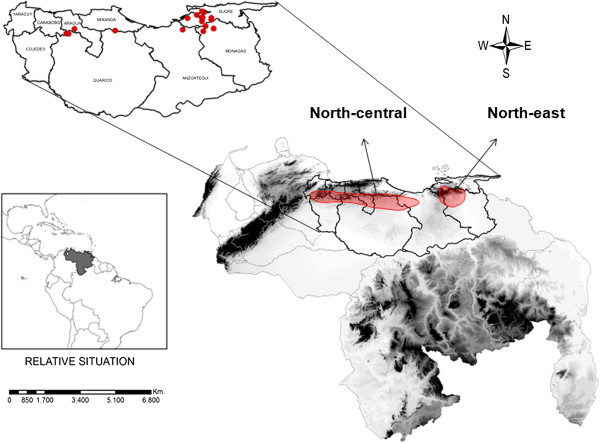
Map of Venezuela. Map of Venezuela (including topographic layer) showing the nine administrative boundaries (States) where the onchocerciasis has been endemic in the northern region of the country. Red areas over the map represent the two endemic foci extent. Red points over the enlarged States correspond to those communities (sentinel and extra-sentinel) were regular in-depth epidemiological evaluations (EEPs) were conducted in order to monitor the impact of treatment on parasite transmission in both foci.